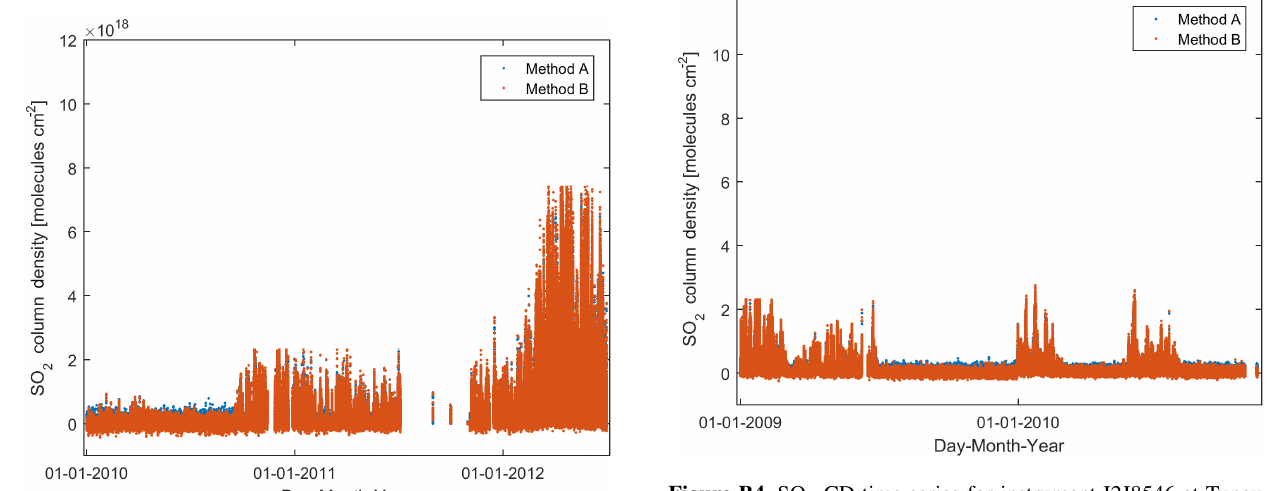
Figure B4. SO 2 CD time series for instrument I2J8546 at Tungu-